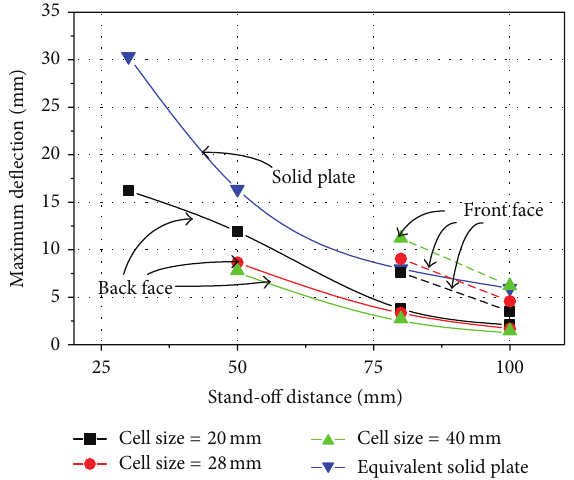
Figure 14: Comparison of the center deflection of the sandwich panel front face, back face, and equivalent weight solid plate versus the stand-off distance. 𝑡 𝑓 = 2.0 mm; 𝑡 𝑐 = 1.0 mm; 𝑡 𝑠 = 5.8 mm.